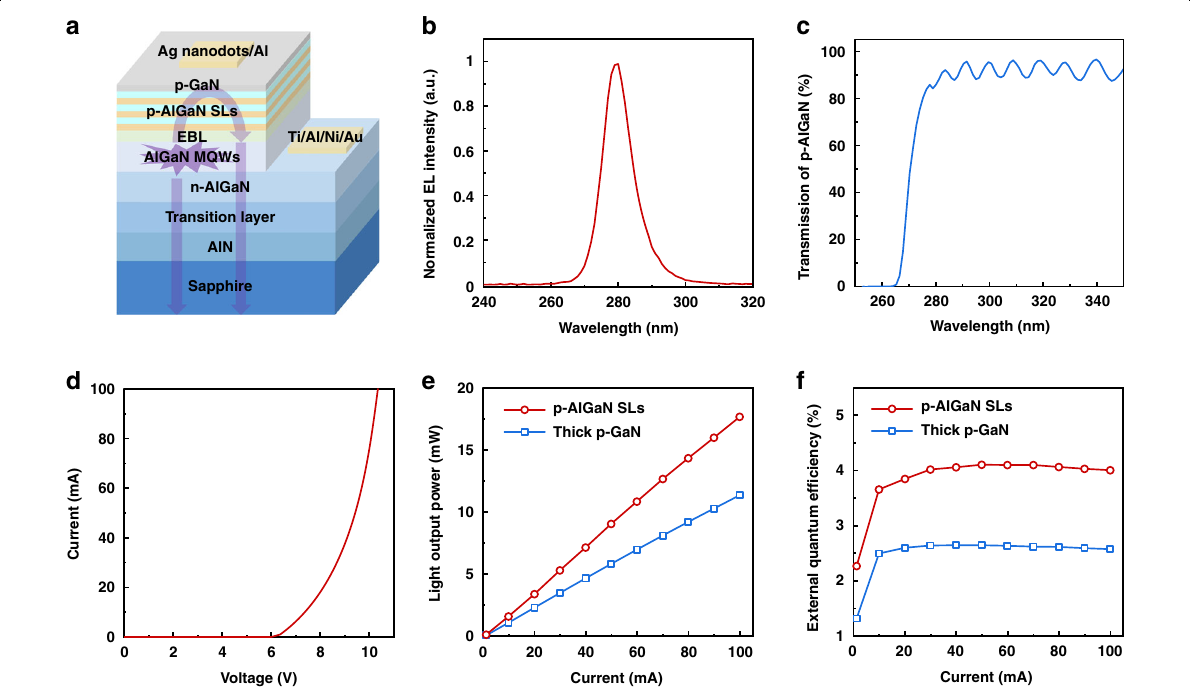
Fig. 4 Performance of DUV-LEDs fabricated with desorption-tailored Al-rich p-AlGaN SLs. a Schematic illustration of DUV-LEDs with desorption-tailored p-AlGaN SLs. b EL spectrum (at 100 mA) of DUV-LEDs. c Transmission spectrum of the desorption-tailored p-AlGaN SLs (without the p-GaN contact layer). d I – V curve of DUV-LEDs with the p-electrode of complex Ag nanodots/Al. e, f Dependence of the LOP and EQE on the injection current for DUV-LEDs with desorption-tailored p-AlGaN SLs and thick p-GaN,